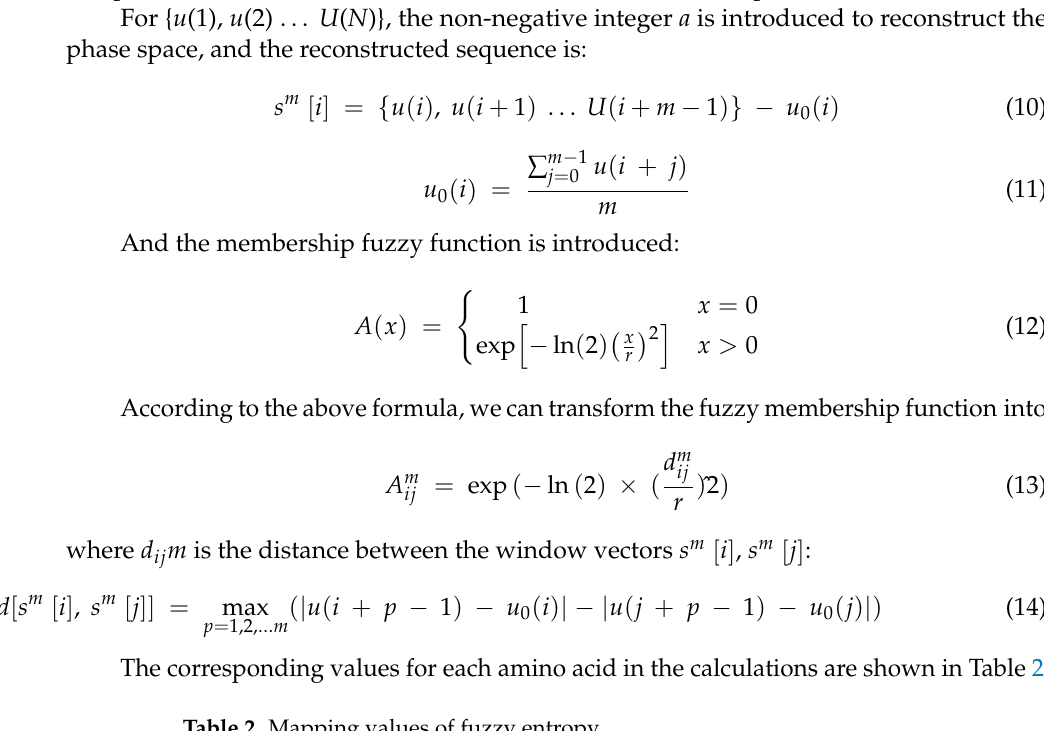
Table 2. Mapping values of fuzzy